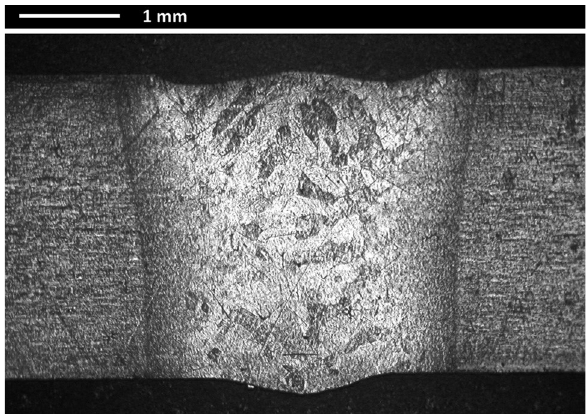
Figure 3. Cross-section micrograph of the specimen corresponding to the center point of the plan.